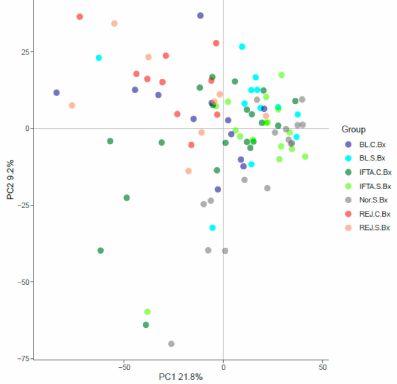
Figure 1. Principal component analysis of the microarray and histological diagnosis in for cause and surveillance biopsies. REJ-C, rejection in biopsies for cause ( n = 12); Normal-S, normal surveillance biopsies ( n = 17); REJ-S, rejection in surveillance biopsies ( n = 6); BL-C, borderline changes in biopsies for cause ( n = 13); BL-S, borderline changes in surveillance biopsies ( n = 12); IFTA-C, interstitial fibrosis and tubular atrophy in biopsies for cause ( n = 20); IFTA-S, interstitial fibrosis and tubular atrophy in surveillance biopsies ( n =